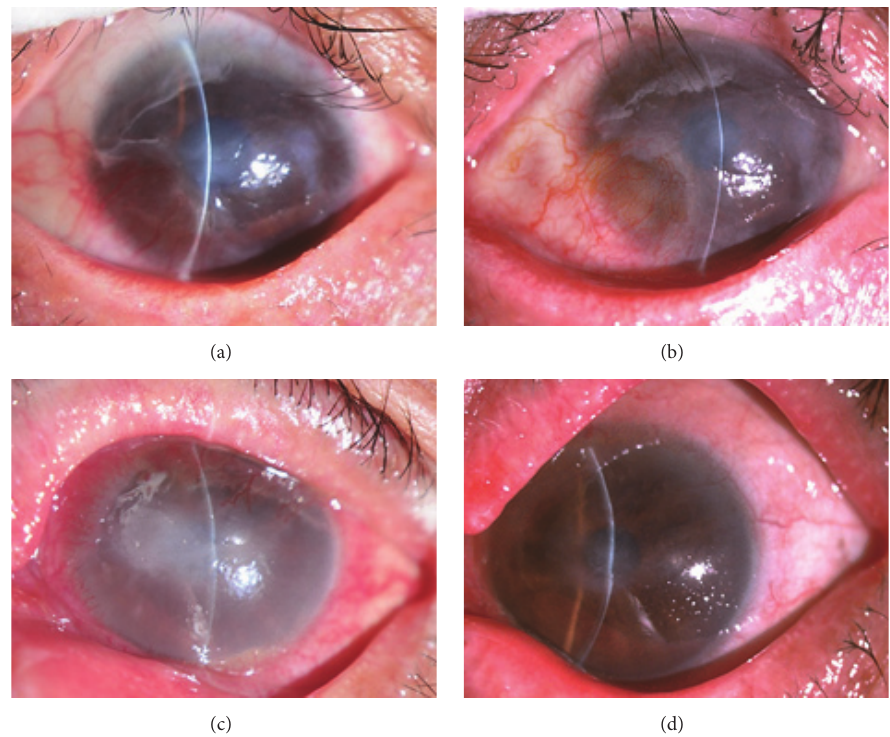
Figure 2: Slit-lamp photographs showing the treatment course of nonhealing corneal ulcers. (a) Patient 1 : the preoperative uncorrected visual acuity was finger counting. The size of the ulcer was approximately 4.0 × 3.0 mm. The surrounding tissue displayed infiltration and edema. (b) At 1 month after surgery, the corneal ulcer was completely cured, with the relief of corneal opacity, and the postoperative uncorrected visual acuity was 0.1 (1.0log MAR). (c) Patient 2 : the preoperative uncorrected visual acuity was hand motion. The ulcer was approximately 5.0 × 2.5 mm. Evident stromal necrosis, edema, and anterior chamber hypopyon were observed. (d) At 1 month after surgery, the corneal ulcer was healed, with the relief of corneal edema, and the postoperative uncorrected visual acuity was 0.1 (1.0log MAR).